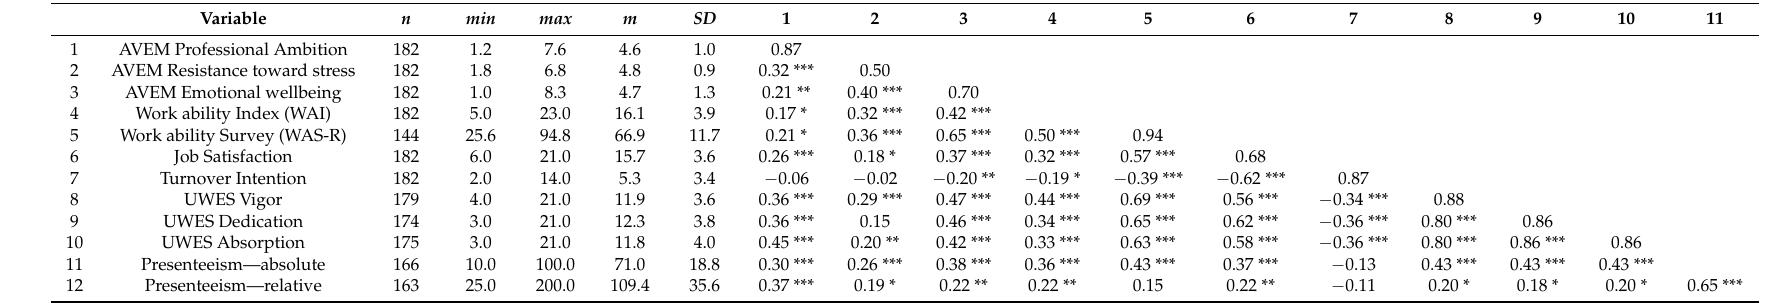
Table 3. Correlation matrix of the AVEM, WAI, WAS-R, Job Satisfaction, Turnover Intention, the Utrecht Work Engagement Scale (UWES) Vigor, Dedication, and Absorption, as well as absolute and relative Presenteeism with internal consistency—if applicable—in the main diagonal.